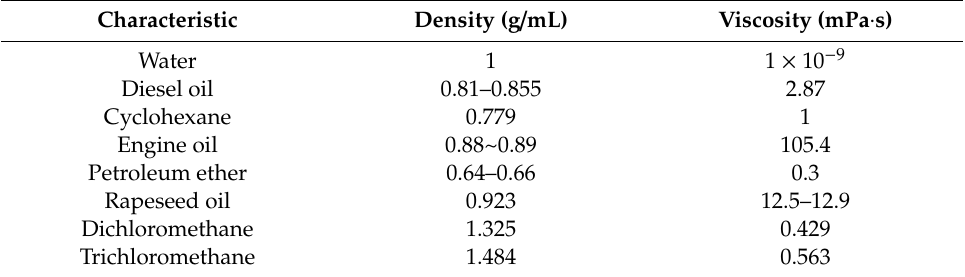
Figure 10. The permeability coefficients of the water outlet and oil outlet when filtering different oils. Table 1. Types and characteristics of oil.